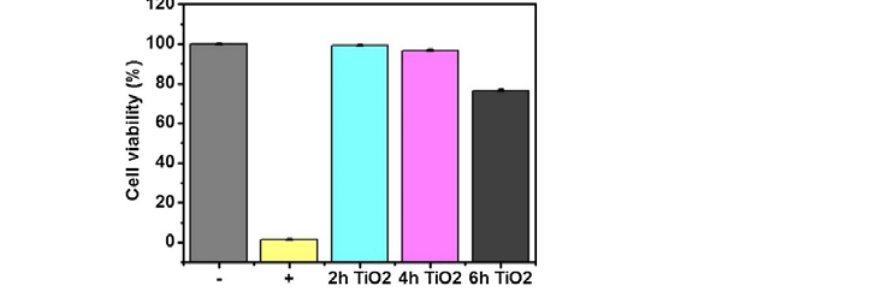
Figure 4. Cytotoxicity study of TiO 2 films with respect to nucleation time. Reprinted with permission from Ref. [41]. Copyright 2017, Elsevier.